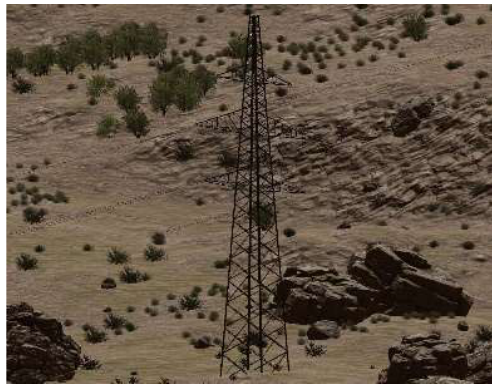
Figure 5. The imported electric tower.